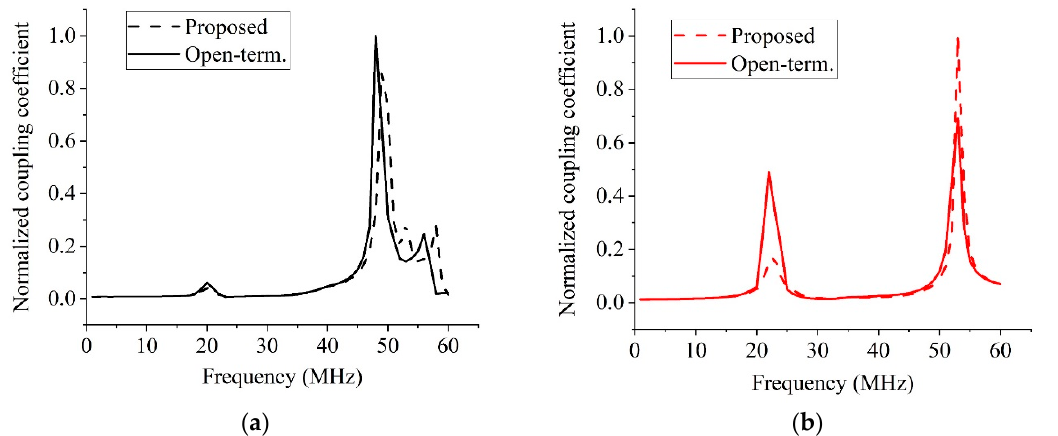
Figure 10. Measured normalized coupling coefficient at distance of 8 cm for open-terminated methods: ( a ) Case #1 and ( b ) Case #2.